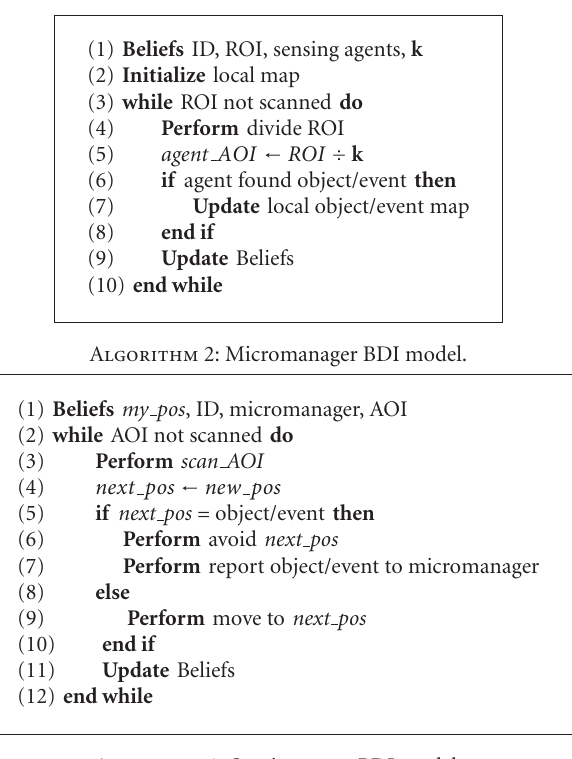
Algorithm 3: Sensing agent BDI model.